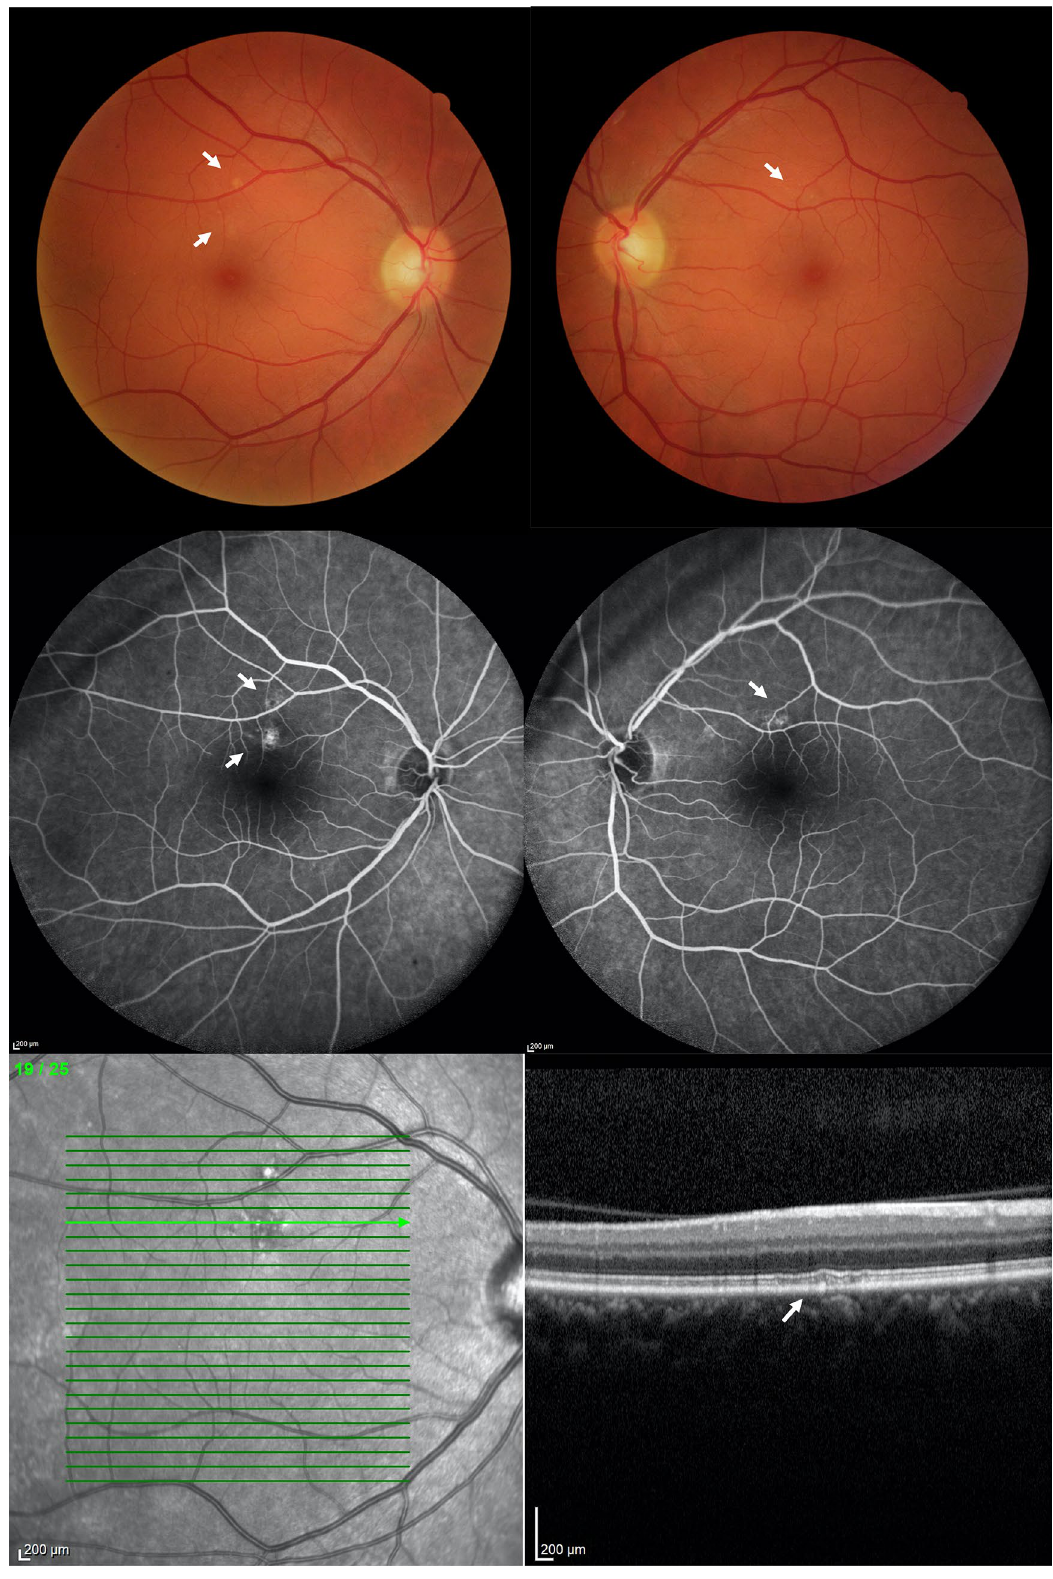
Figure 1. Ocular Fundus multimodal imaging of a 48-year-old man (critical case) 128 days after first symptoms of COVID-19. Color fundus pictures of both eyes showing white-yellowish dots (arrows). Midphase fluorescein angiography pictures of the RE (middle left) and LE (middle right) showing transmission hyperfluorescence in the retina lesions 195 days after first symptoms of COVID-19. Optical coherence tomography (OCT) of the right eye shows hyporreflectivity in the retinal pigment epithelium and ellipsoid layers, and discontinuation of photoreceptors’ outer segments (arrow). (Fig. 1 is composed of six individual photographs, using the Microsoft ® PowerPoint for Mac software, version 16.47 (21,031,401), author